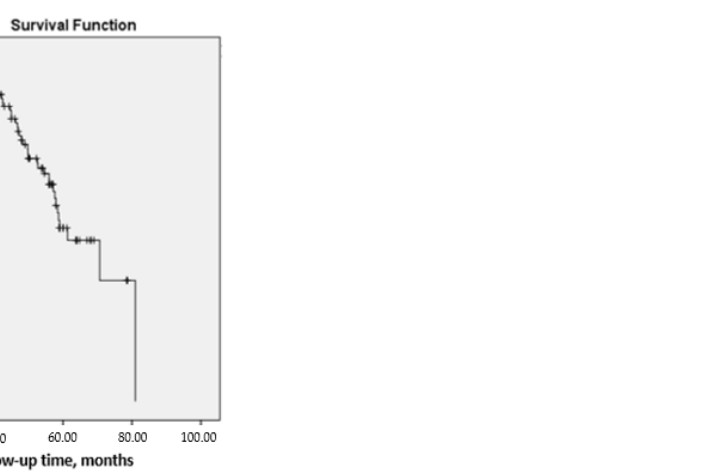
Figure 1. Survival curve was measured from v0 until the end of follow-up (v60) or progression/death in 116 patients at risk with RA-ILD under treatment with DMARDs. Table 3. Progress of symptoms and lung function at the end of follow-up of 116 patients with RA-ILS taking DMARDs. Variable